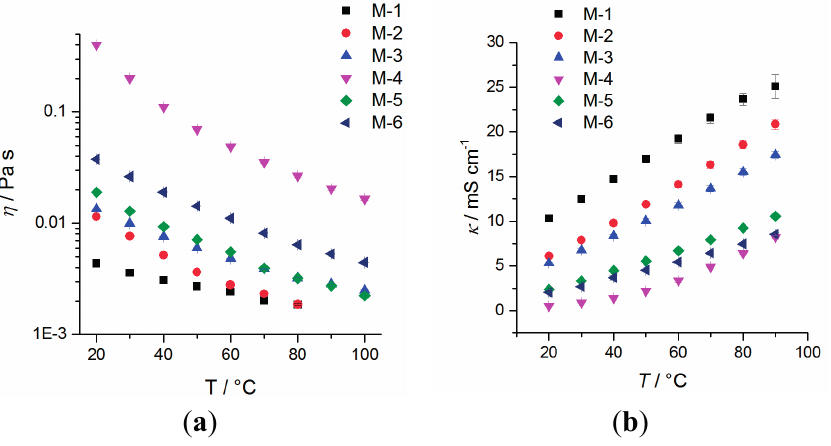
Figure 3. DSC measurements of mixtures M- n ( n = 1–6) in closed cup during cooling ( a ) and heating ( b ) at 10 K · min − 1 ( exo down).